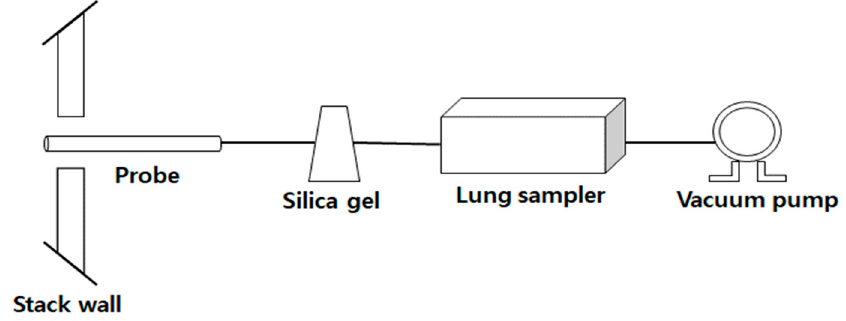
Figure 1. Greenhouse gas sampling using lung sampler.